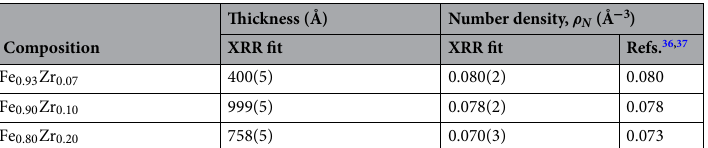
Table 1. The thicknesses and number densities obtained by fitting the XRR patterns using the GenX software 35 . The number density values reported in the literature 36,37 are also included.